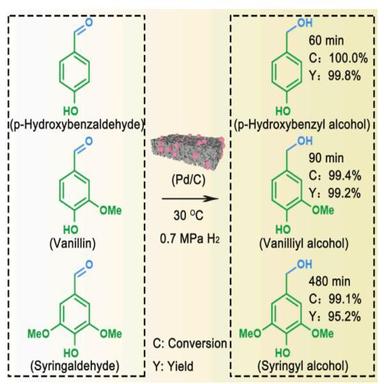
Hydrogenation reactions of other lignin-derived aldehydes.